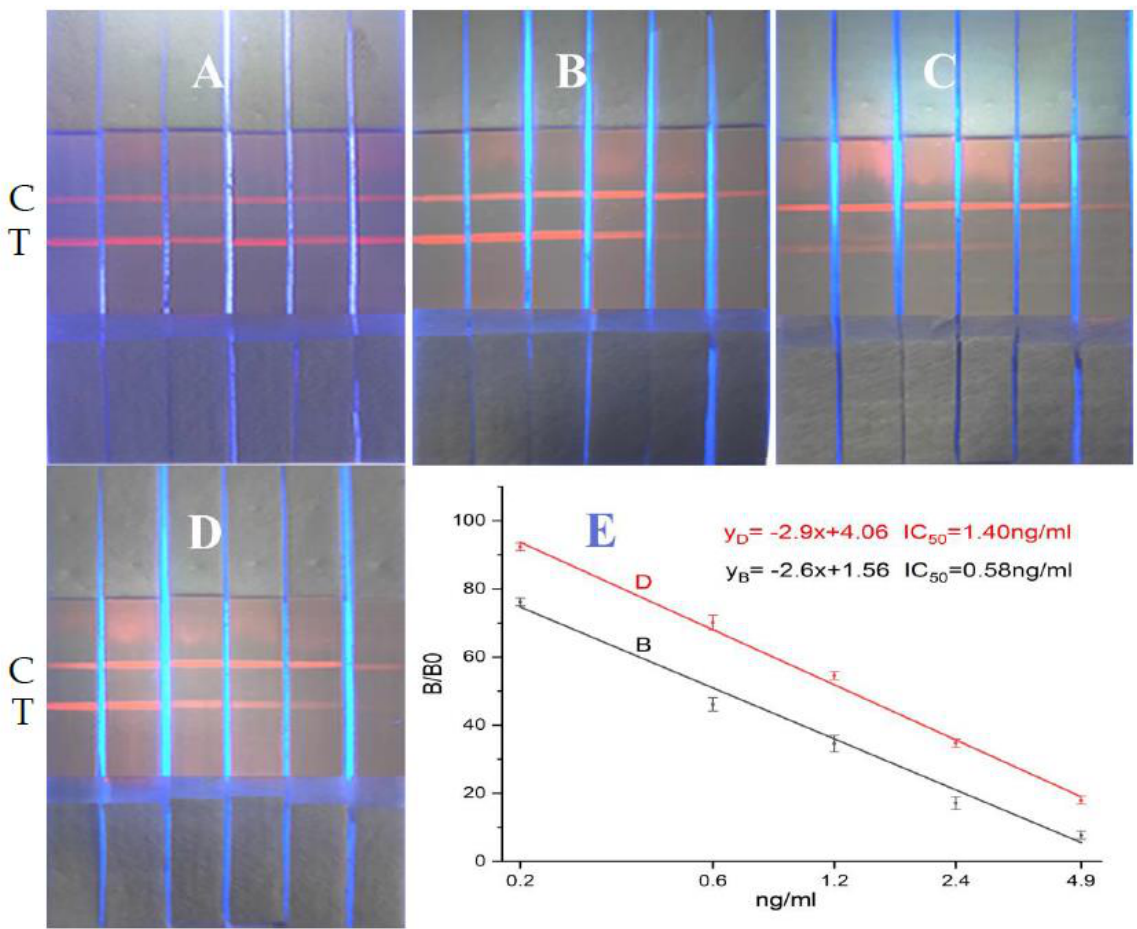
Figure 3. QD-based immunochromatographic results of the four coating agent/anti-ACP antibody pairs. (C represents control line, T represents the detection line. Four kinds of conjugated antigens (A: ACP-BSA; B: Imidacloprid – BSA; C: Imidaclothiz – BSA; D: Thiacloprid – BSA) were coated at the concentration of 1 mg/mL; 0, 0.1, 0.3, 0.9, 2.7, and 8.1 ng/mL of ACP standards from left to right. Figure3E(D)represents the standard curve for 1G2 anti-ACP antibody/imidacloprid – BSA pair; Figure 3E(B)represents the standard curve for anti-ACP antibody/thiacloprid – BSA pair).